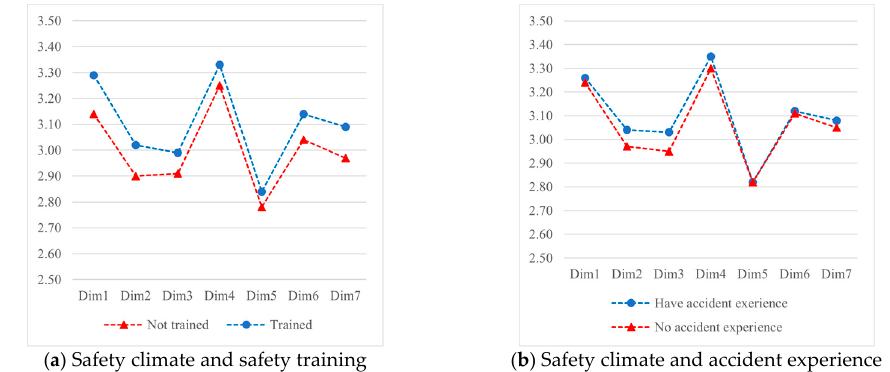
Figure 5. Safety climate scores based on ( a ) safety training and ( b ) accident experience.